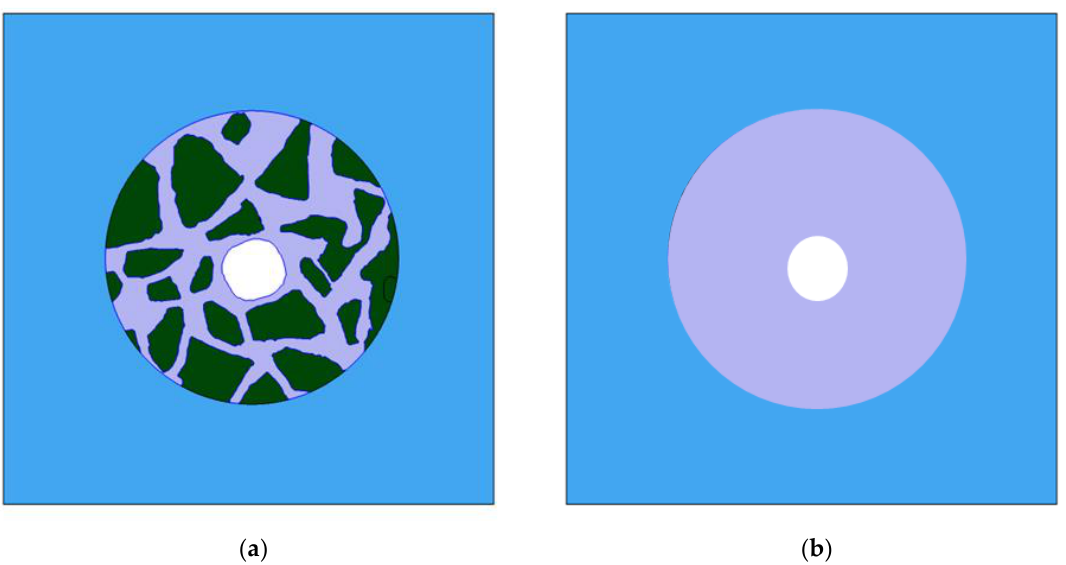
Figure 19. Simulation domains for concrete ( a ) and mortar ( b ) samples. Four regions can be identi- fied: electrolyte (blue), liquid in pores of cement (dark grey), aggregates (dark green), and central rebar (white).